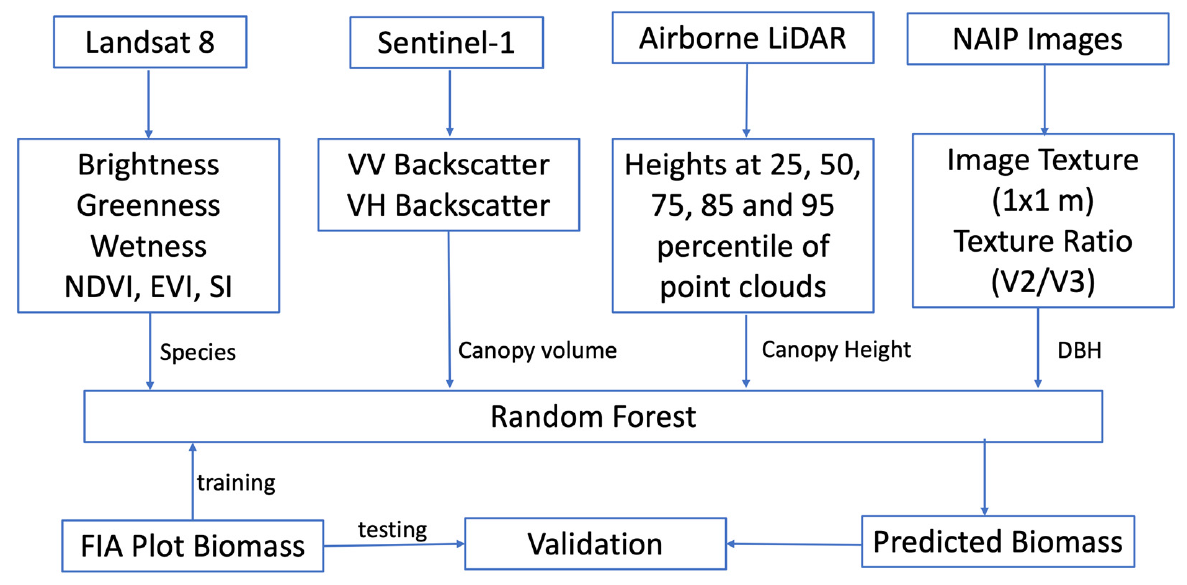
Figure 2. Flow chart for biomass model development. The predictive accuracy by Random Forest is based on the “out-of-bag” samples. Although the biomass used for calibration and validation are both from the FIA sampling plots, the validated samples are not used in the calibration. Table 1 lists all remote sensing features derived from LiDAR, RaDAR (Sentinel-1), multispectral (Landsat 8), and very high-resolution (NAIP) data that were used for biomass mapping with RF. Due to the large number of feature variables, we implemented an au- tomatic feature selection with KnowGRRF, which is an R package developed by Guan and Liu [62] for statistical computation, to identify the most important remotely sensed predictors for biomass estimation. In order to use KnowGRRF, we first need to generate a regularization coefficient for each variable by running the RF to map FAGB with all variables included. The regularization coefficient for each variable is calculated using Equation (5) based on the variable importance value from the initial RF